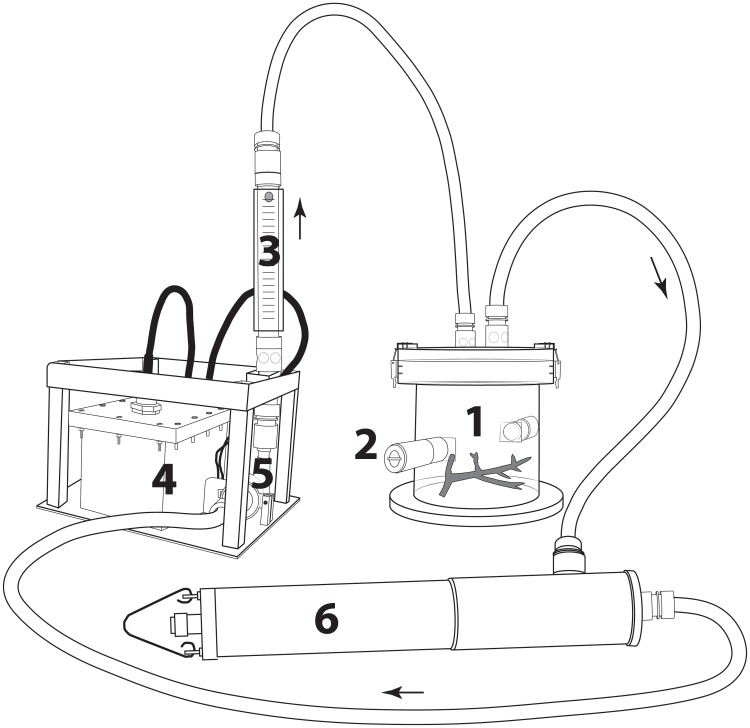
Schematic representation of the experimental system.1- Benthic chamber with a coral colony, 2- Seawater sampling port, 3- Flow meter, 4- Battery in a waterproof housing, 5- Adjustable submersible pump, 6- Multiparameter probe. The arrows indicate the direction of the water flux.